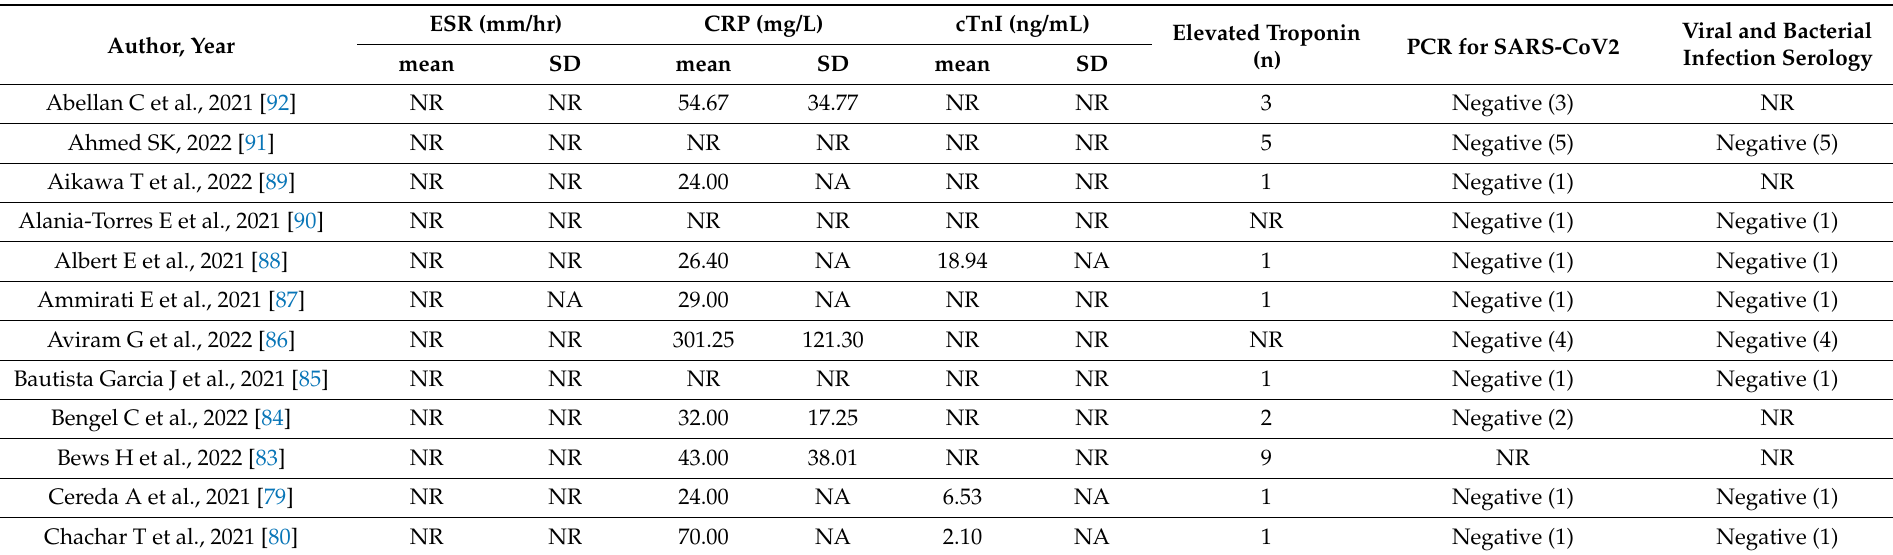
Table 4. Major Laboratory Findings on Admission